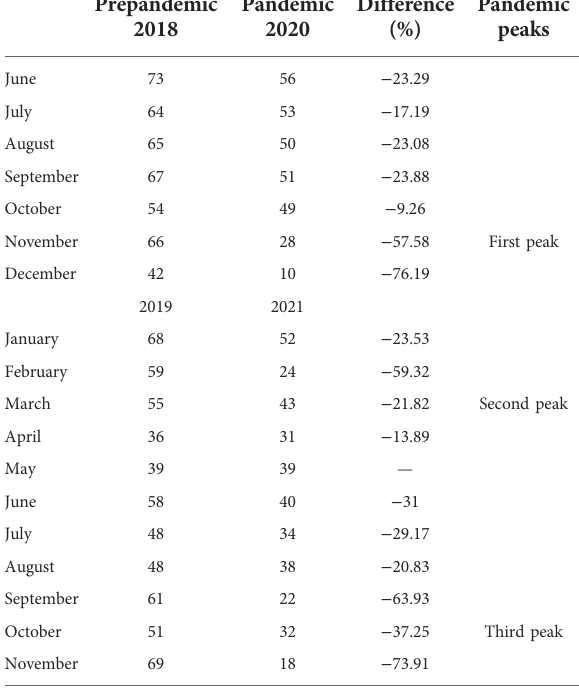
TABLE 5 Hospital admissions/month